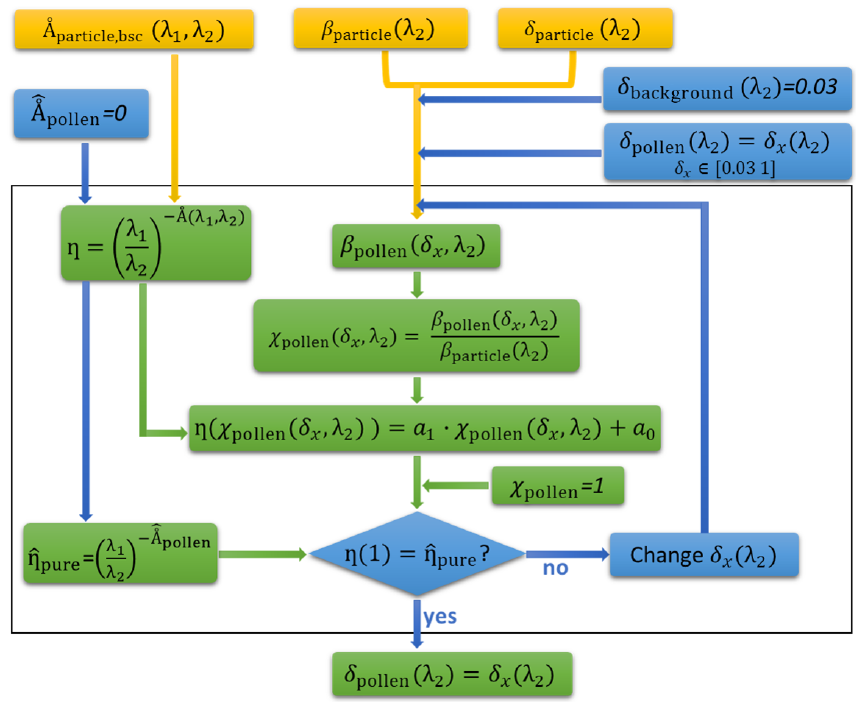
Figure 5. Flow chart of the inverse model for the retrieval of the depolarization ratio value for pure pollen. The orange boxes are for the measured parameters (or simulated output from the direct model), the blue boxes for the assumptions/manual input and the green boxes for the estimations/calculations. A detailed description is in Sect. 3.2. The wavelength pair (λ 1 ,λ 2 ) is selected to be (355,532), (532,355), or (1064,532) in this